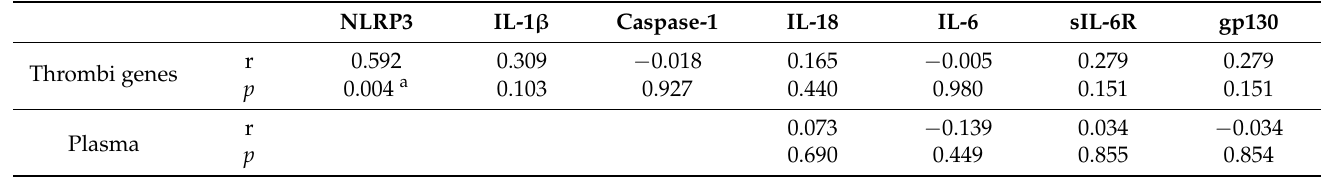
Figure 3. Scatterplot presenting the correlation between the ratio AV + /AV − MVs (PS externalization) and NLRP3 gene expression in the thrombi. Abbreviations: PS—Phosphatidylserine. Table 4. Bivariate correlations between the ratio AV + /AV − MVs (PS externalization) and inflammasome gene expression in the thrombi and corresponding circulating markers.